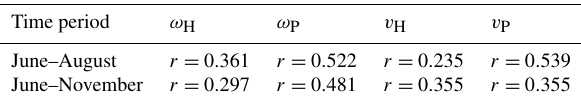
Table 2. Correlations (r) between the detrended C mlo − cgo anoma- lies and indices of mean transport ω H , ω P , v H , and v P , averaged